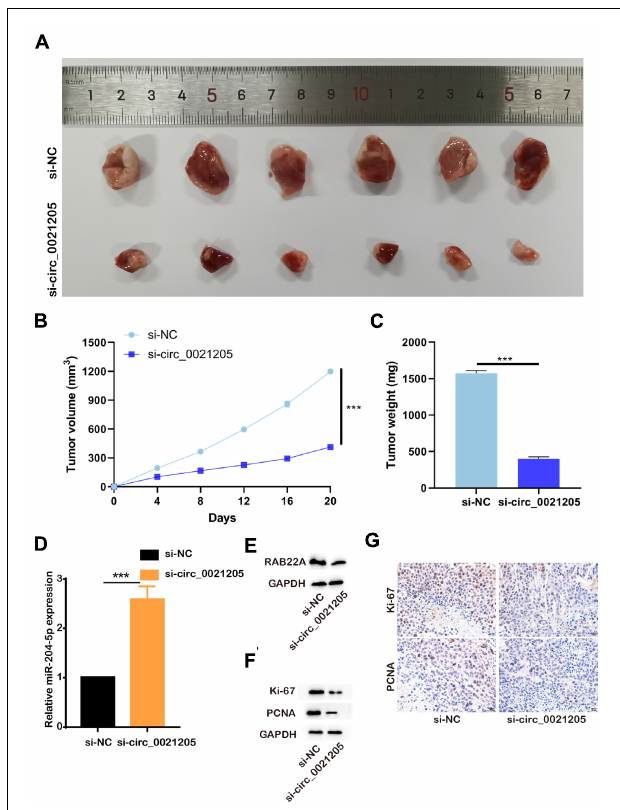
FIGURE 6 | Circ_0021205 knockdown inhibits the tumorigenesis of CCA in vivo . (A) The presentative image of xenograft tumors was showed. (B) Tumor volumes were recorded every 4 days. (C) Tumor weights were recorded. (D) Relative miR-204-5p expression after down-regulation of circ_0021205 was measured using qPCR. (E) The levels of RAB22A in si-NC and so-circ_0021205 tumor tissues were investigated using western blotting. (F) The levels of proliferation makers, Ki-67 and PCNA, were investigated using western blotting. (G) The proliferation properties of si-NC and so-circ_0021205 tumor tissues were detected using immunohistochemistry staining. *** P < 0.001.